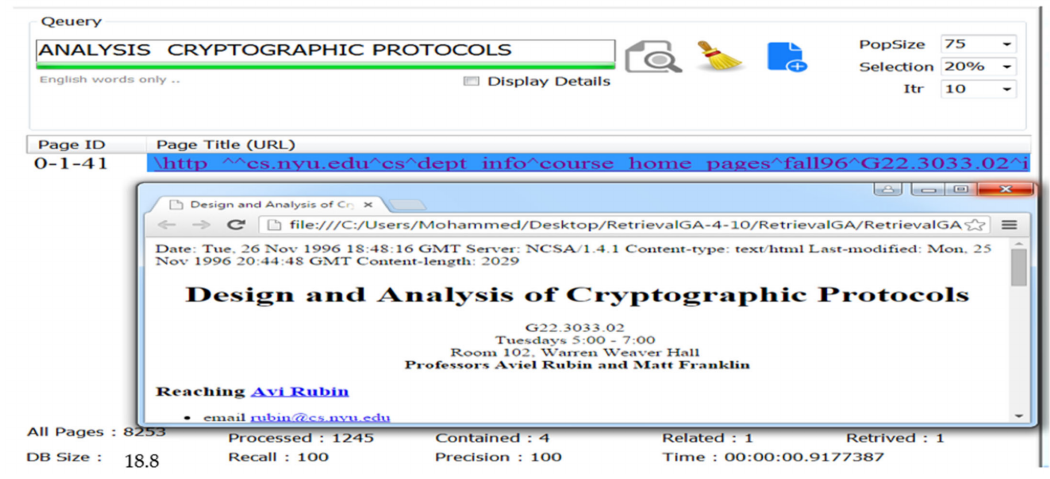
Figure 12. The general execution of ADIM-MGA with integrated